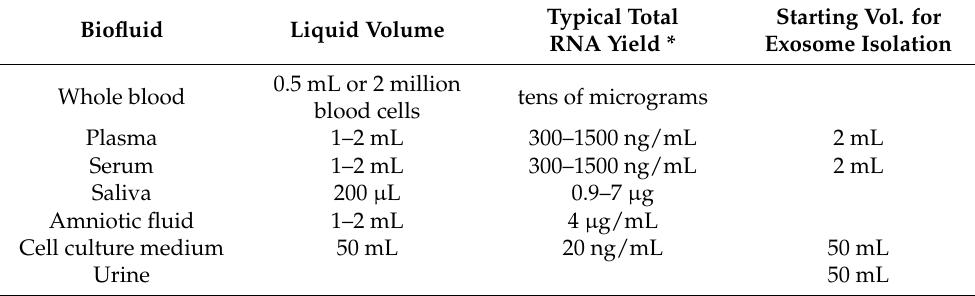
Table 4. Biofluid volumes for circRNA microarray.